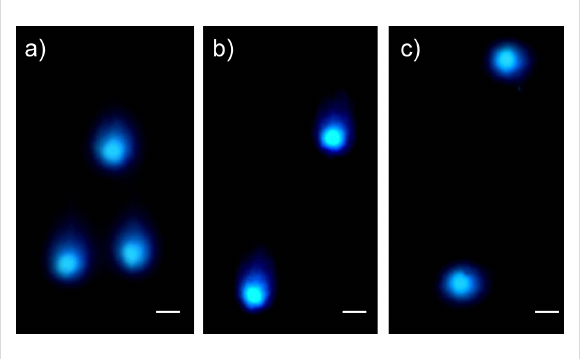
Figure 4: The representative comet-assay images obtained after 20 min of electrophoresis of a) control cells, b) cells incubated with C 60 fullerene at concentration of 0.1 mg/mL, and c) cells treated with Cis at 0.15 mg/mL. The bars correspond to 10 µm.